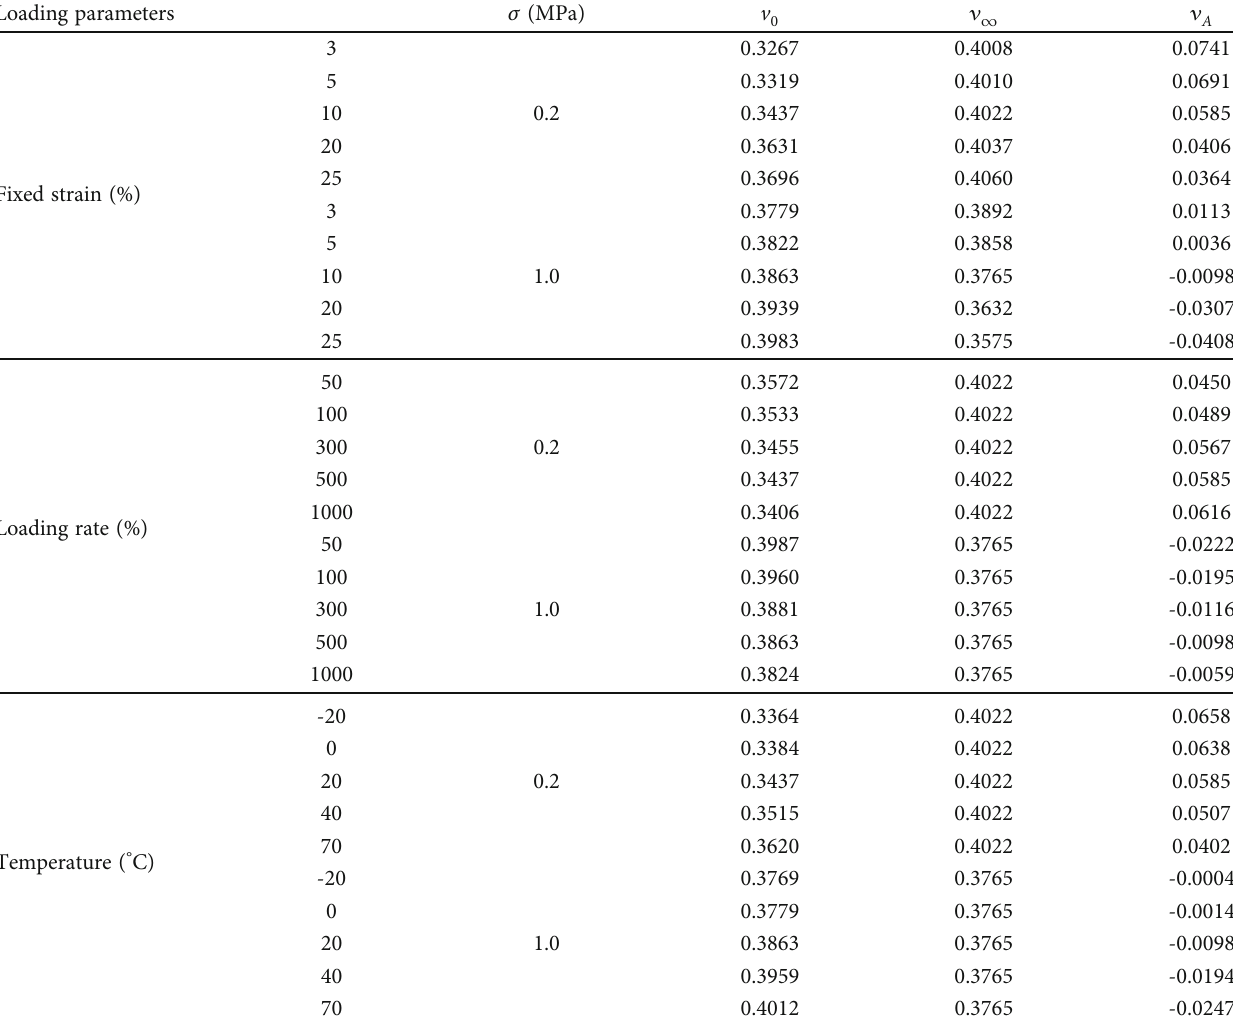
Table 5: Characteristic parameters of Poisson ’ s ratio under di ff erent loading